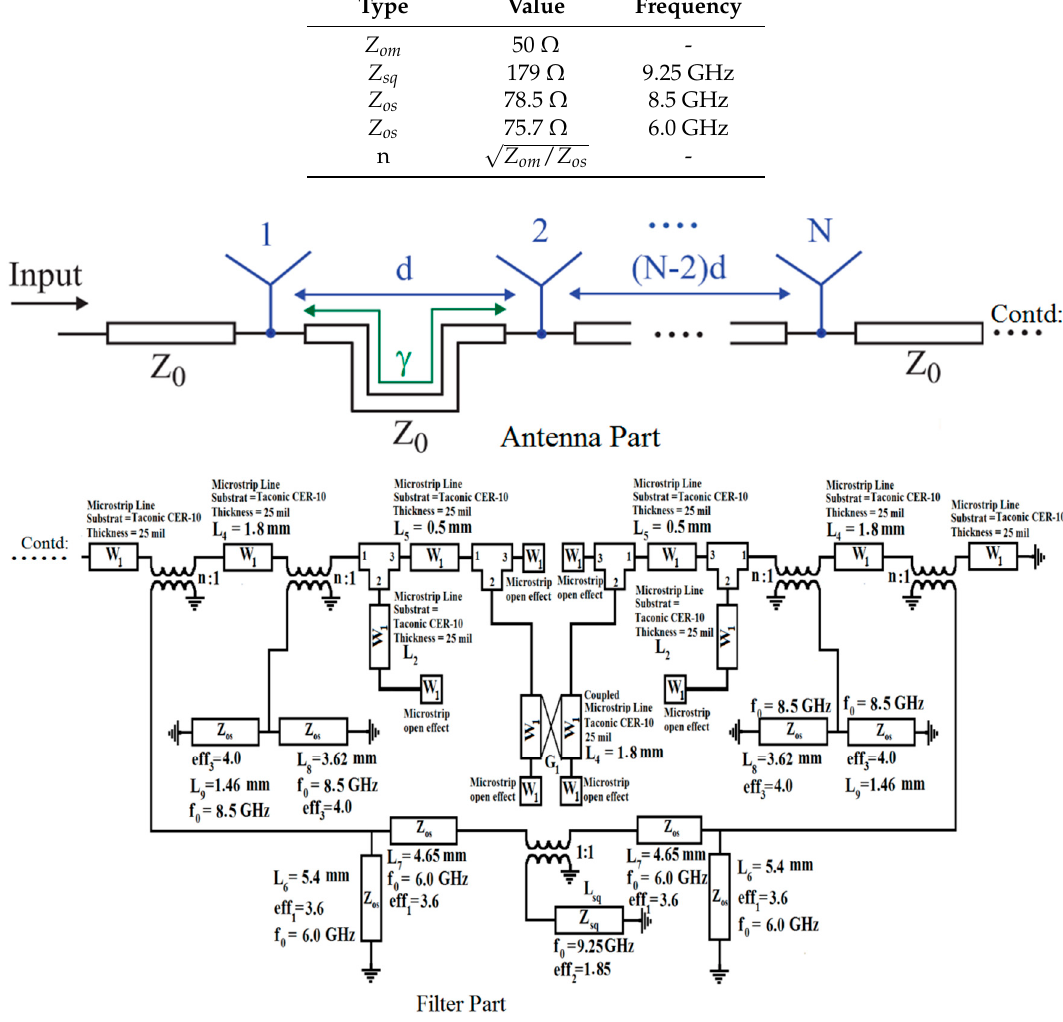
Figure 15. Equivalent circuit model developed for the filter and antenna.